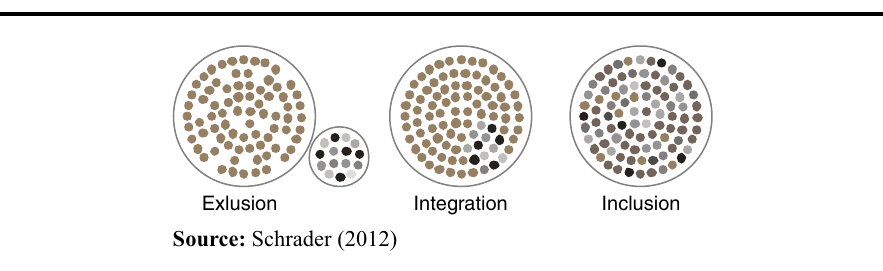
Figure 2 Models of social exclusion, integration and inclusion of people with